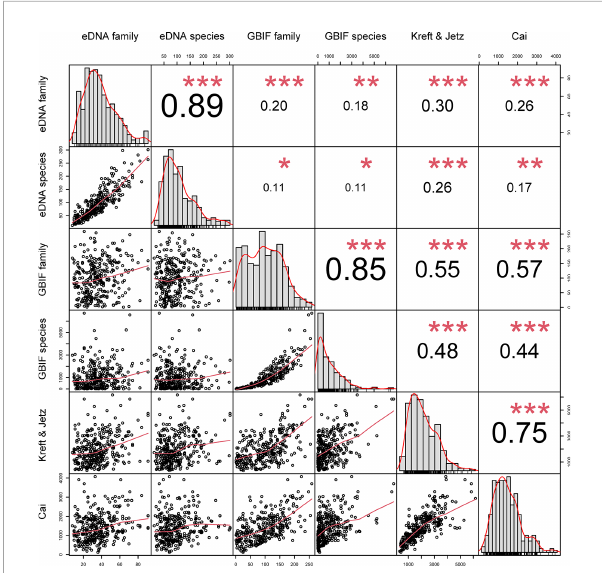
FIGURE 1 Correlations between eDNA, GBIF, Kreft & Jetz and Cai datasets. Numbers show correlation strength and direction, red asterisks show signi fi cance (*p < 0.05; **p < 0.01; ***p <